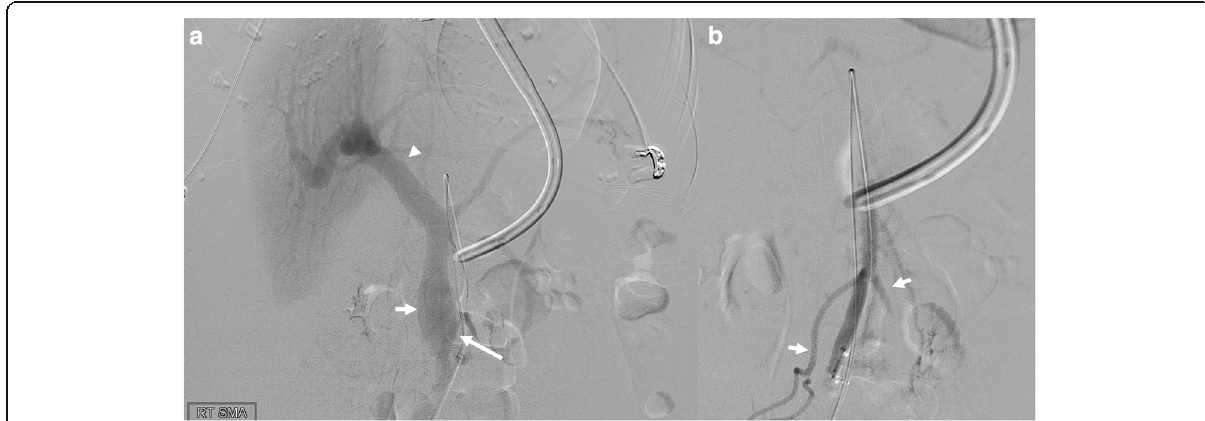
Fig. 2 Pre- and post-embolization angiography of superior mesenteric artery ( a ) Digital subtraction angiography (DSA) prior to embolization demonstrates superior mesenteric arteriovenous fistula (long arrow) draining into dilated superior mesenteric vein (short arrow) and portal vein (arrowhead) ( b ) DSA following embolization with AMPLATZER Vascular Plug II (AGA Medical, Golden Valley, Minnesota) shows complete occlusion of fistula with preservation of major superior mesenteric artery intestinal branches (short